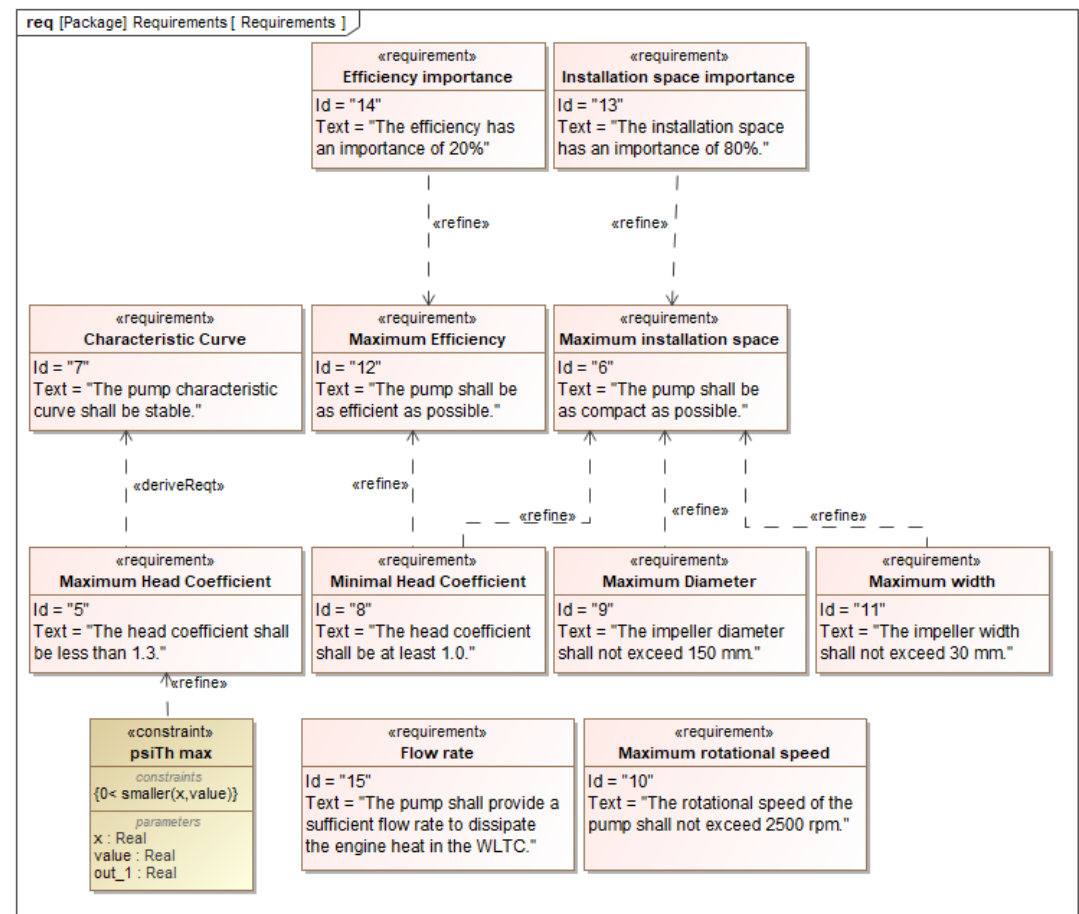
Figure 6. Requirements of the electric coolant pump.